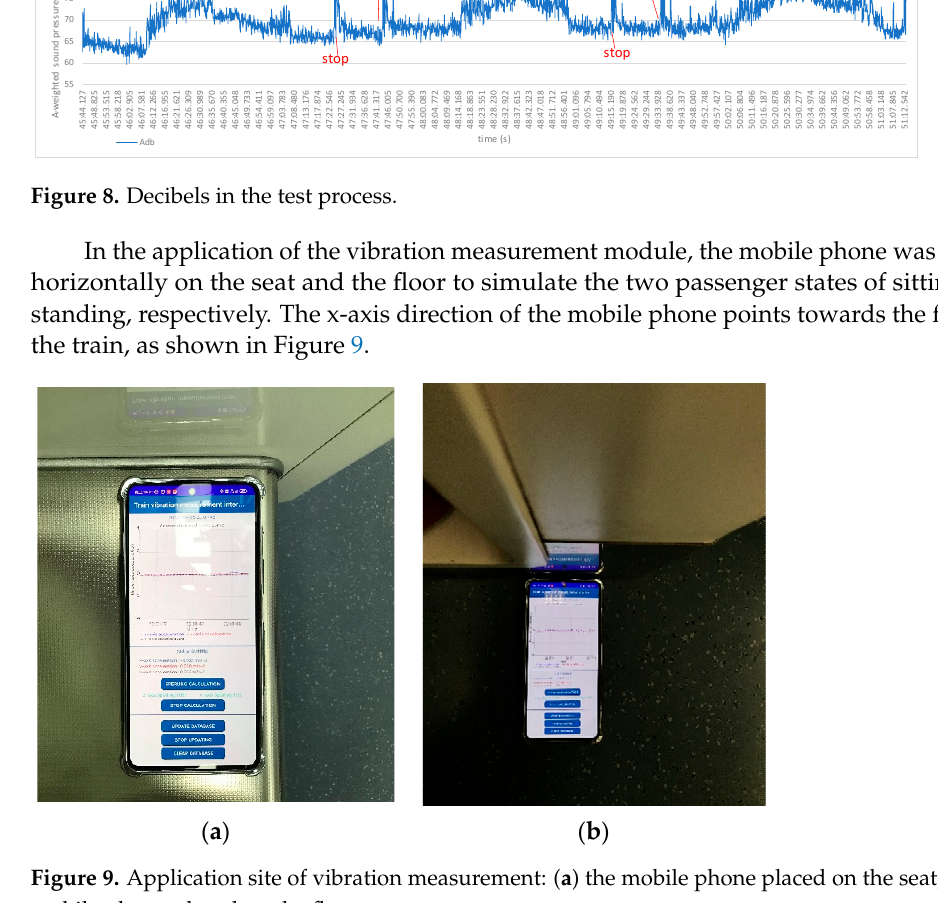
( b ) Figure 10. Three-way acceleration: ( a ) three-axis acceleration from Shuxin Avenue station to Xipu station; ( b ) three-axis acceleration from Tianyu station to Wangcongci station.